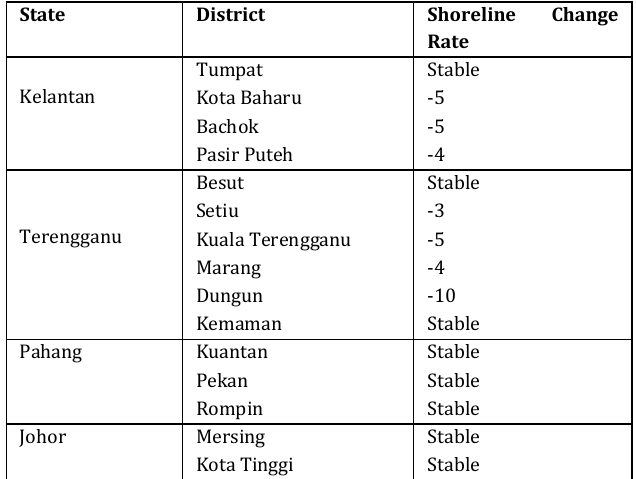
Table 2: Shoreline change rate (erosion and accretion) along the East Coast of Peninsular Malaysia [20].